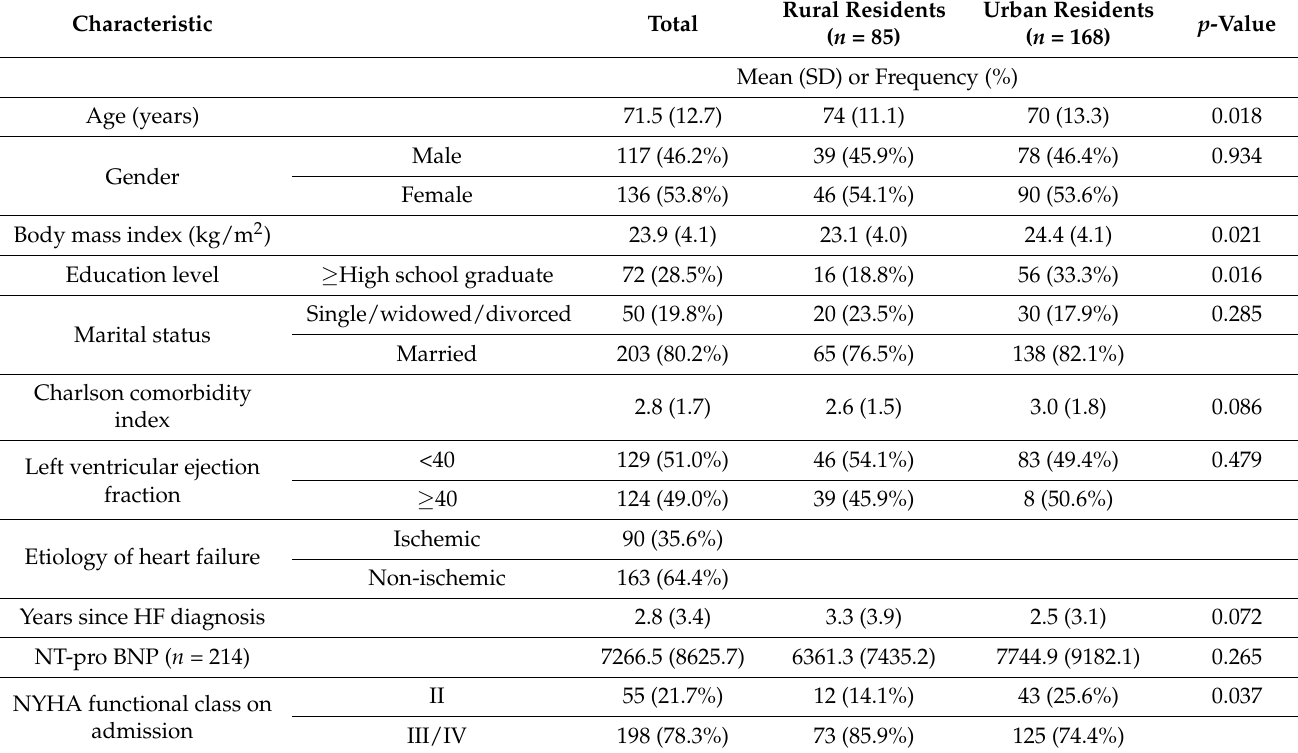
Table 1. Sample characteristics (N =